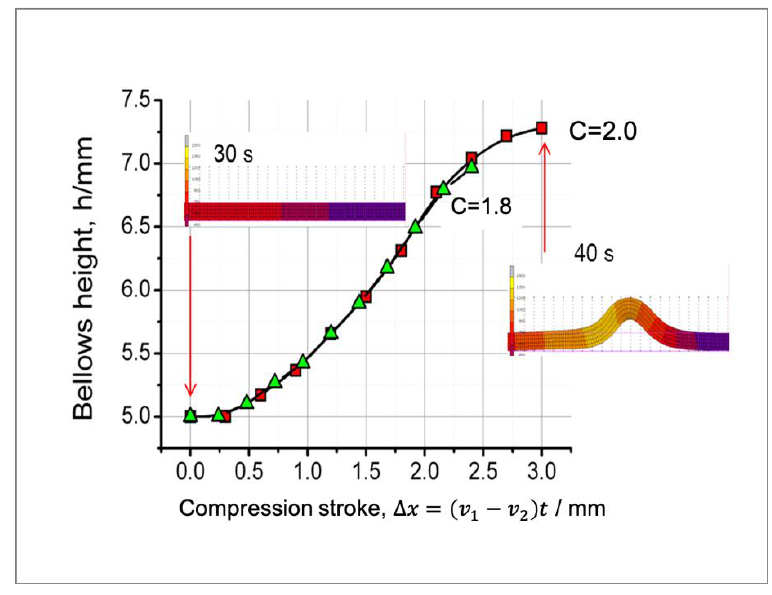
Figure 9. E ff ects of the compression stroke on the bellows Figure 9. Effects of the compression stroke on the bellows heights.